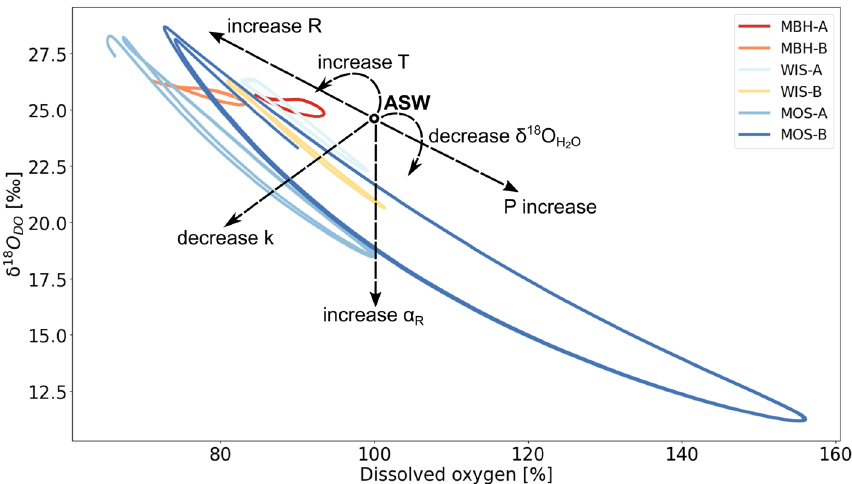
Figure 5. Summary of modelled diel cycles showing dissolved oxygen (DO) saturation versus DO stable isotopes ( δ 18 O DO ) of the streams Mähringsbach (MBH), Wiesent (WIS) and Moosach (MOS) with respective upstream (A) and downstream (B) sites. Processes related to position and range of day-night curves are photosynthesis (P), ecosystem respiration (R), respiration isotope fractionation factor (α R ), gas exchange coefficient (k), stable water isotopes ( δ 18 O H2O ) and water temperature (T). The empty black circle represents air saturated water (ASW) at a DO saturation of 100% and δ 18 O DO value of + 24.6‰ 31